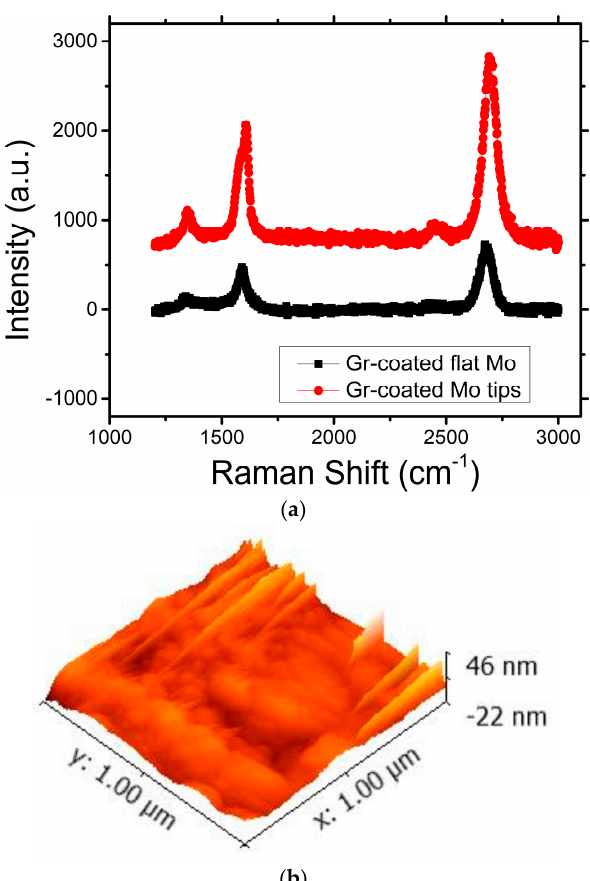
Figure 7. Experimental results of ( a ) the Raman shift of graphene-coated flat Mo chip and graphene-coated Mo tips; and ( b ) surface roughness of the graphene on the Mo tips.